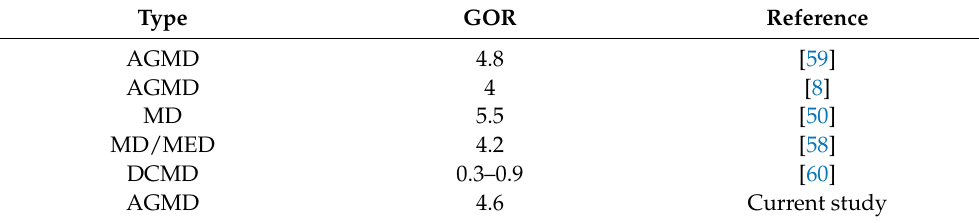
Table 2. Summary of gain output ratio for di ff erent MD con fi gurations from the literature.